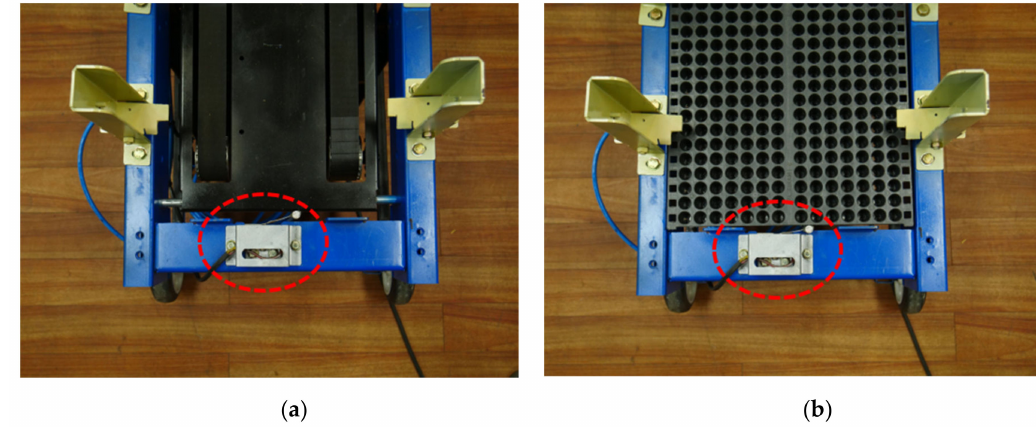
Figure 5. View of limit switch: ( a ) noncontact situation and ( b ) contact situation of limit switch with pot